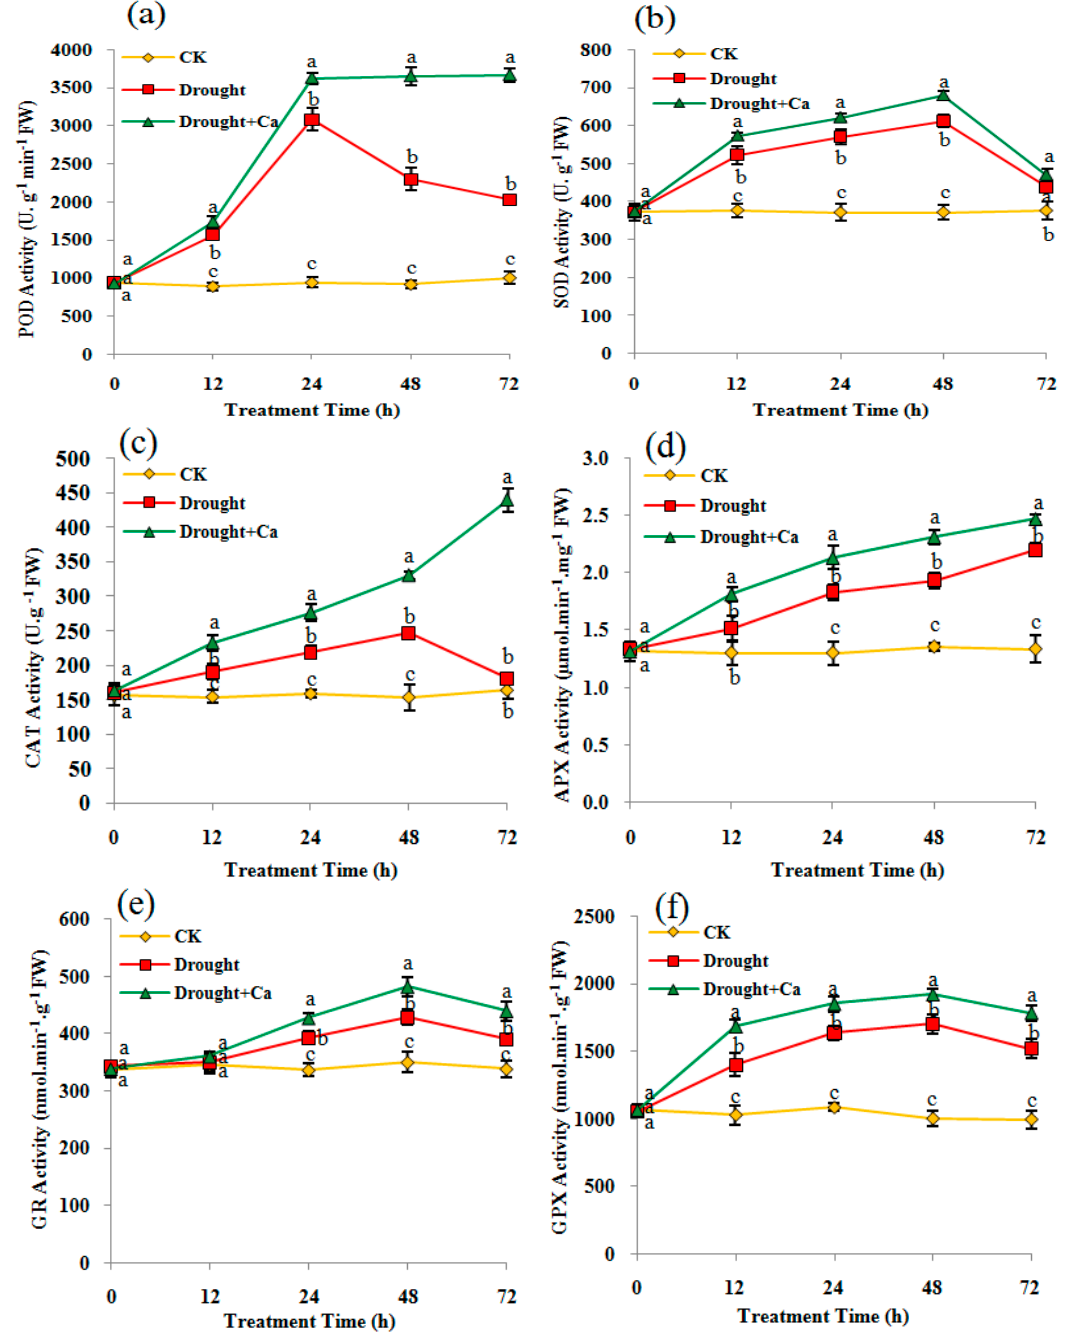
Figure 5. ( a ) Peroxidase (POD) activity, ( b ) Superoxide dismutase (SOD) activity, ( c ) Catalase (CAT) activity, ( d ) Ascorbate peroxidase (APX) activity, ( e ) Glutathione reductase GR activity, ( f ) Glutathione peroxidase (GPX) activity in C. glauca leaves under drought stress and amended with Ca 2+ . The details of the treatments are given in the legend of Figure 2.